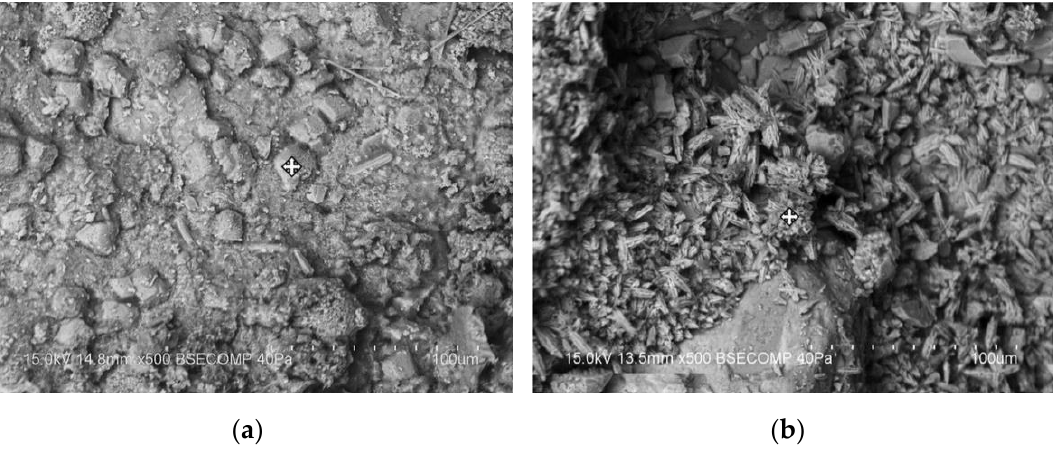
Figure 5. SEM observation of ( a ) calcite and ( b ) aragonite [48].